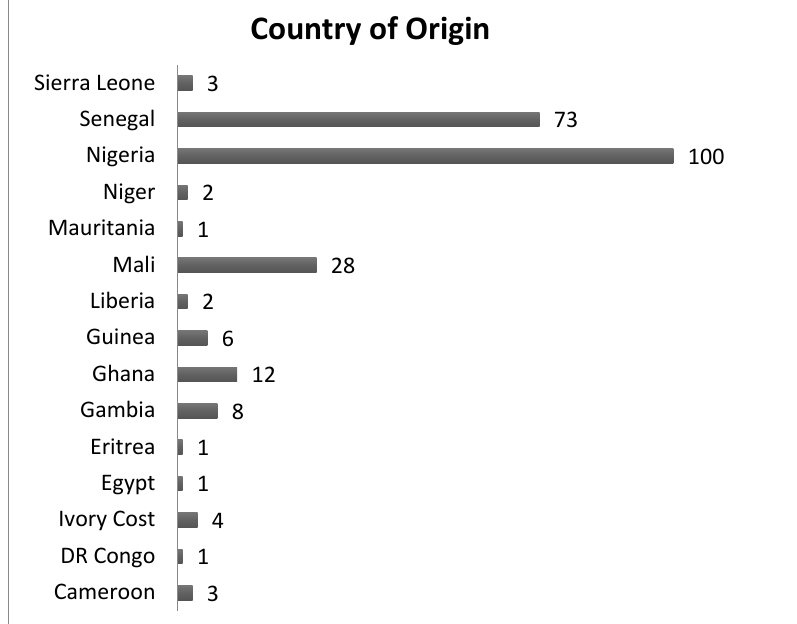
Figure 1. Number of study subjects according to country of origin.